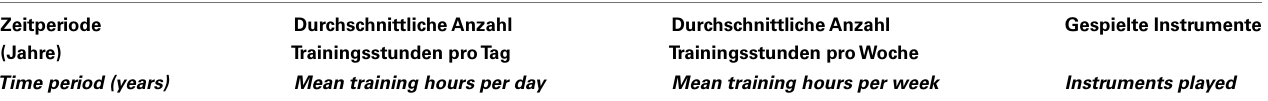
TableA1 | Evaluation derTrainingsintensität . Evaluation of training intensity